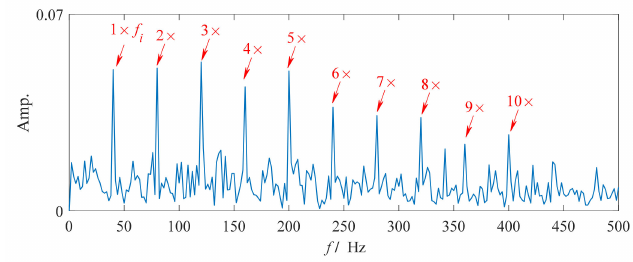
Figure 6. SES of the result shown in Figure 5b.